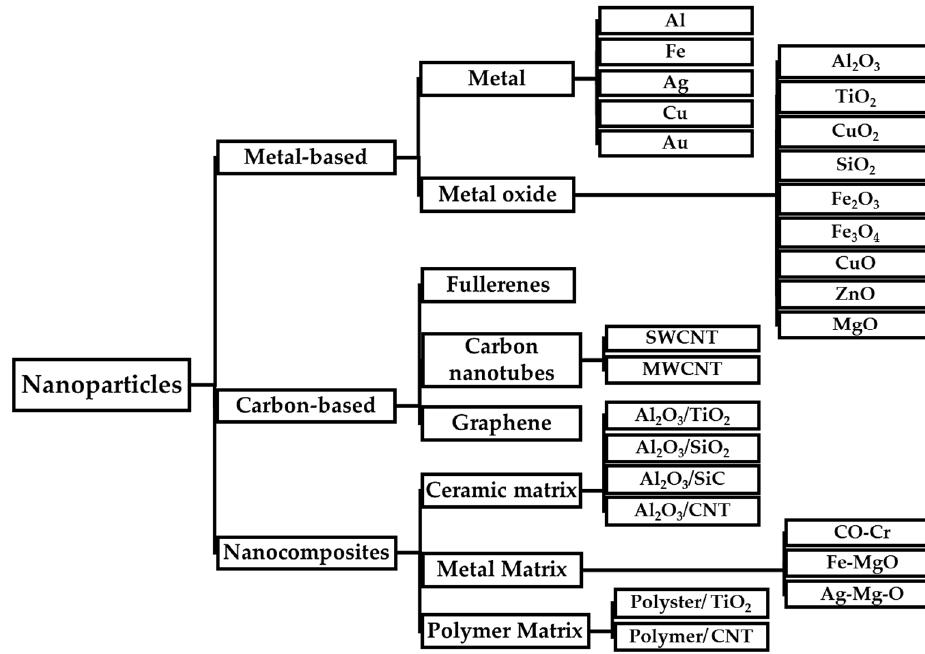
Figure 15. Nanoparticle classification [121].